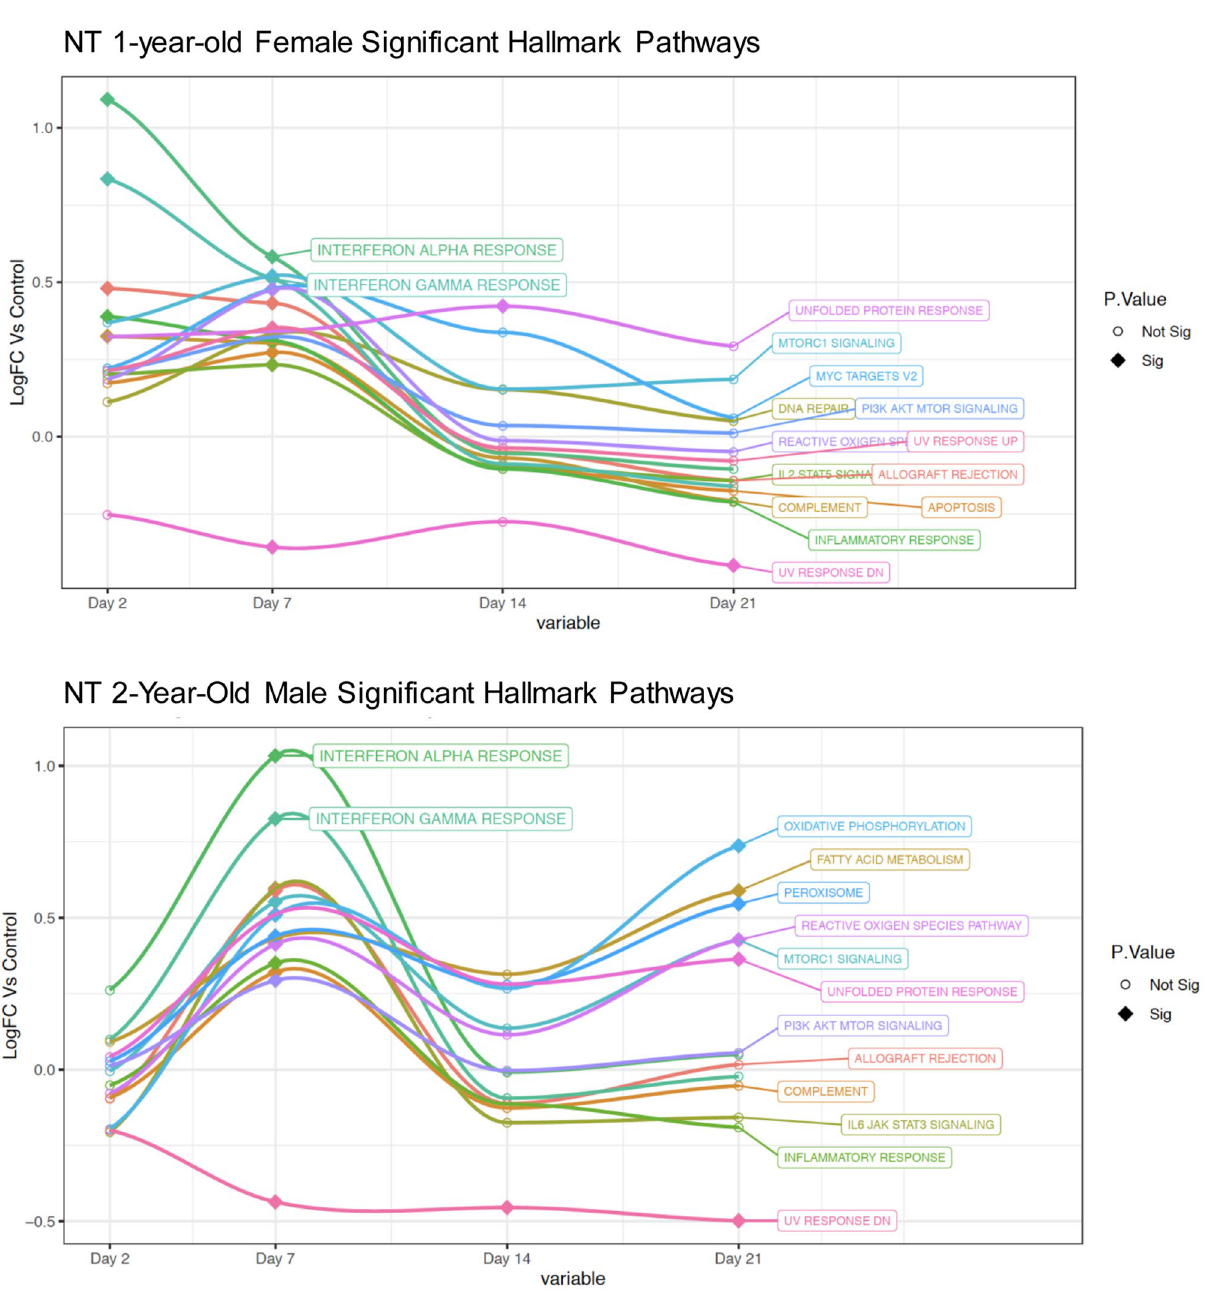
Figure 8. Unique signaling pathway regulation for 2-year-old male ferrets and 1-year-old female ferrets in the upper respiratory tract after SARS-CoV-2 infection. The RNA extracted from the nasal turbinates of 1-year-old females and 2-year-old males at time points post infection with SARS-CoV-2 was sequenced using the Illumina platform. Longitudinal enrichment analysis was independently performed at plotted per experimental group for days 0, 2, 7, 14, and 21 pi. ( A ) Enrichment profiles were created using Hallmark Pathways over the time course for 1-year-ol female ferrets. ( B ) The Hallmark enrichment profiles were plotted over the time course for 2-year-old ferrets. Signaling pathways which were statistically changed (FDR < 0.10) compared to baseline for at least one time point were included: IFN-alpha, IFN-gamma, Unfolded Protein Response, MTORC, MYC Targets V2, DNA Repair, PI3K AKT MTOR Signaling, Reactive Oxygen Species, UV Response, IL2 STAT5 Signaling, Allograft Rejection, Apoptosis, Inflammatory Response, UV Response DN, Peroxisome, Oxidative Phosphorylation, IL6 JAK STAT3 Signaling, and Complement. Filled diamonds represent a time point statistically changed compared to baseline. Open circles represent time points that are not statistically significant compared to baseline. Three ferrets per group per time point were analyzed with the exception of a poor sample in the female on day 7 which did not pass quality